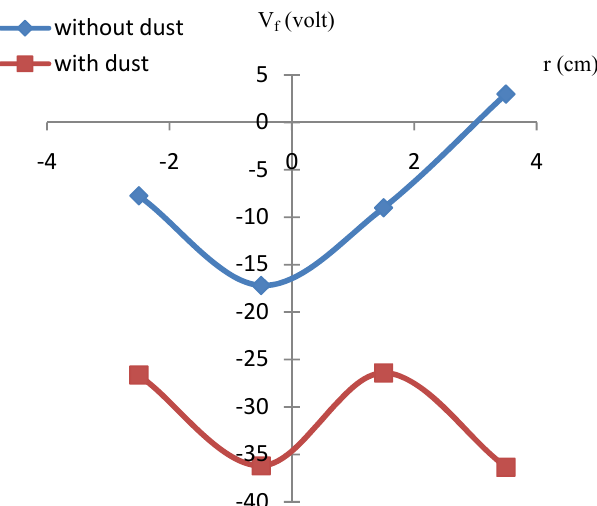
Fig.8:Radial profile of floating potential in the presence and absence of Al dust